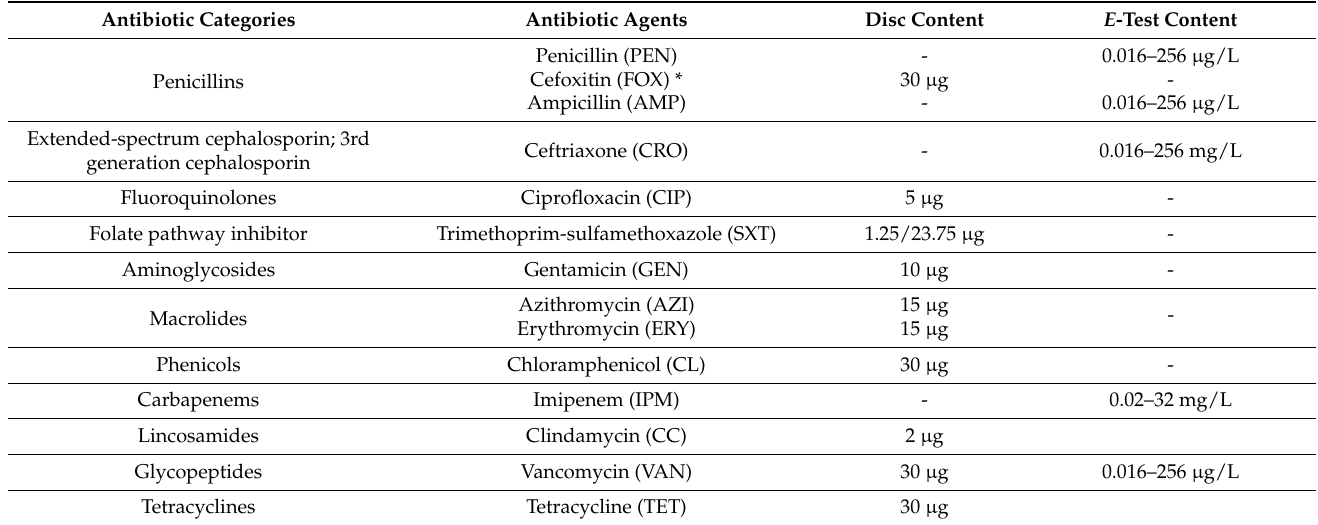
Table 3. Antibiotic categories and antibiotic agents used for susceptibility